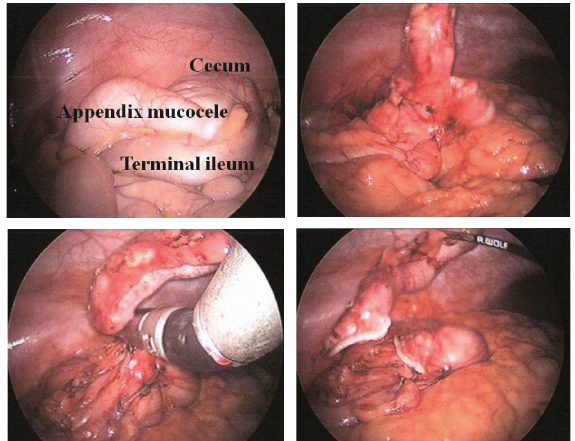
Figure 2: Operative fi ndings: left upper: overview of the right lower quadrant showing appendix mucocele; right upper: the appendix is gently lifted up; left lower: the appendix is stapled just below the base; right lower: the appendix has been stapled, only the mesoappendix is grabbed.